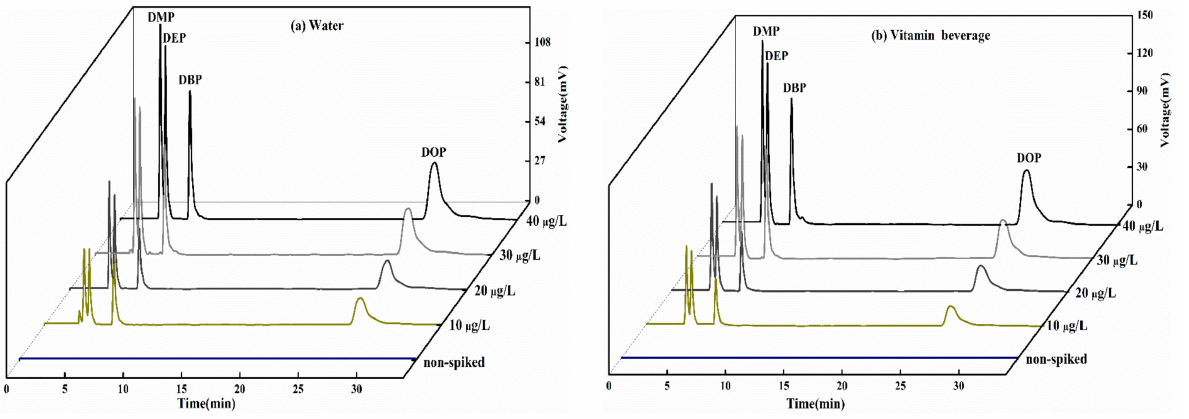
Figure 9. ( a ) Labeled outflow curve of water. ( b ) Labeled outflow curve of vitamin